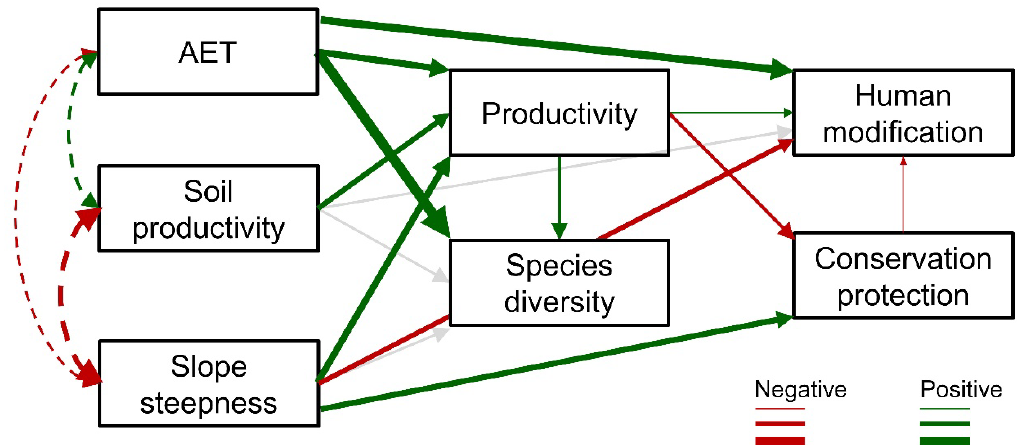
Figure 4. Results of path analysis from the hypothetical path model presented in Figure 2. Significant relationships in path coefficients are highlighted in either red (negative estimates) or green (positive estimates) with the weight of the line varying with the size of the estimates (Table 1). Grey lines represent non-significant paths. Dashed lines show correlations between exogenous variables. AET = actual evapotranspiration, an estimate of climates favorable to plant growth; NPP = net primary productivity.